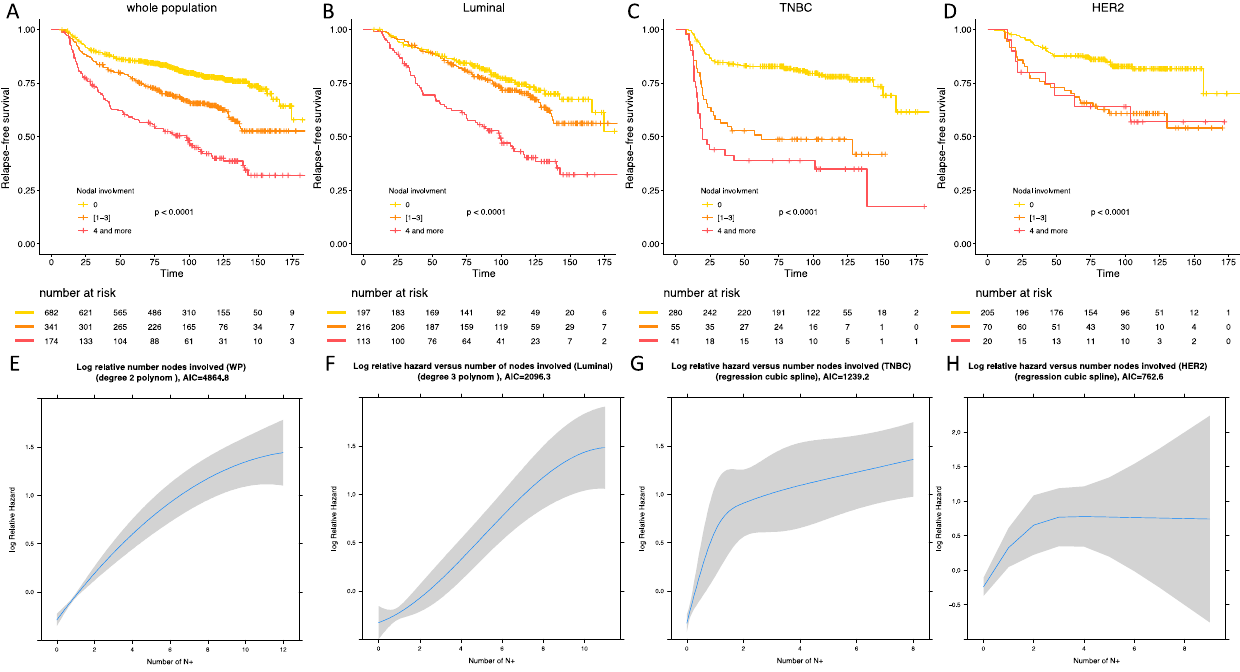
Figure 2. Relapse-free survival according to BC subtype in the whole population ( A ), in luminal BC ( B ), in TNBC ( C ), in HER-2 positive BC ( D ). Statistical models reflecting the association between relapse free survival and nodal status in the whole population ( E ), in luminal BC ( F ), in TNBC ( G ), and in HER-2 positive BC ( H ).